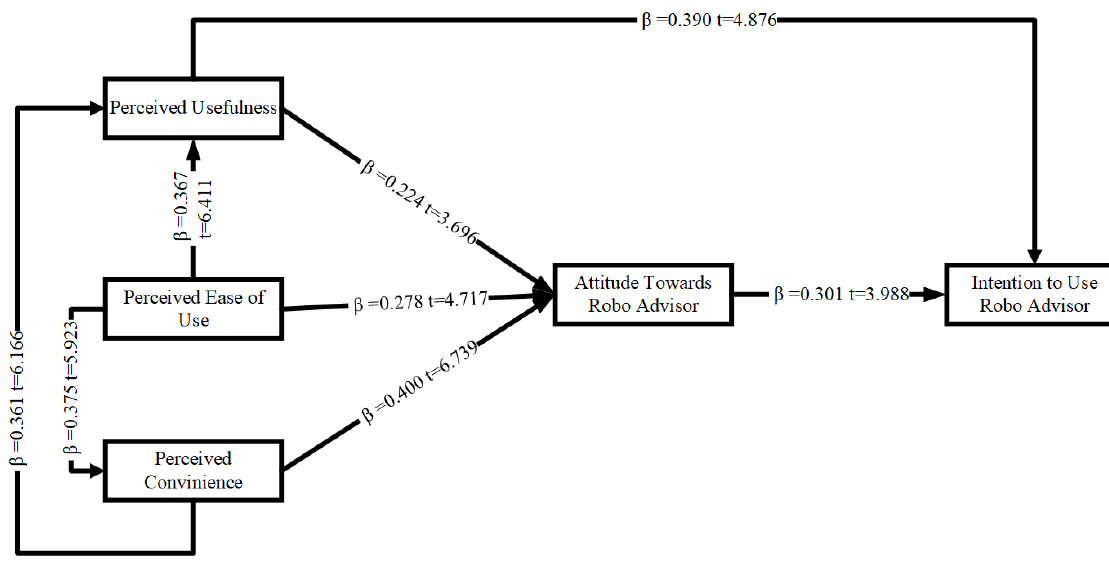
Figure A3. Moderating Effects of TRI Contributors.